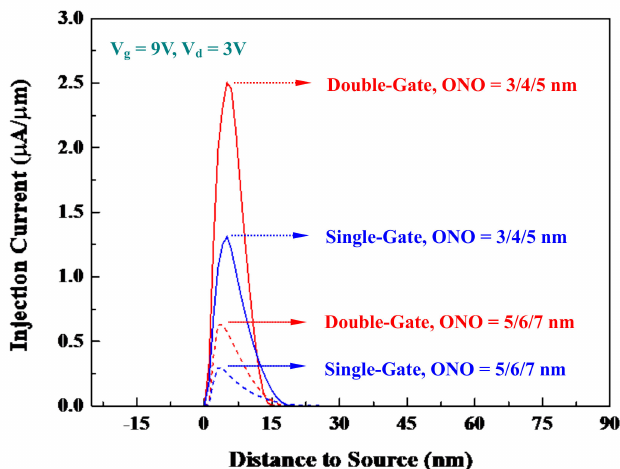
Figure 6. Distributions of electron injection currents in single- and double-gate Schottky barrier cells at programming voltages of V g = 9 V and V d = 3 V.